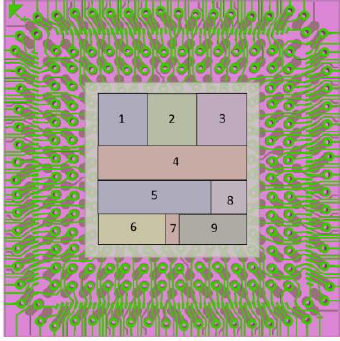
Figure 8. Chip partitioning in nine zones.